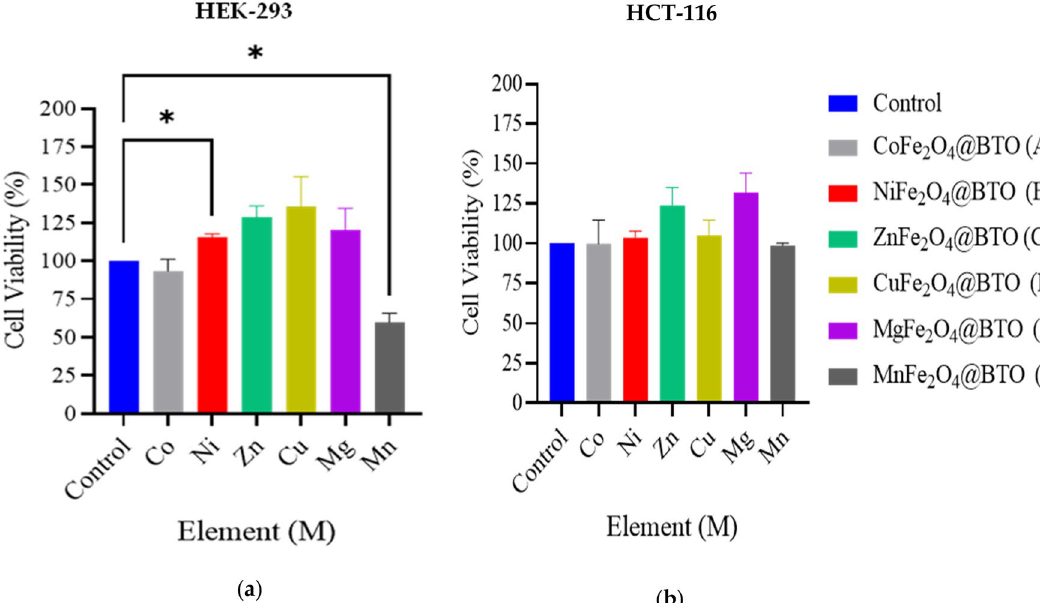
Figure 5. The average cell viability of ( a ) HEK-293 and ( b ) HCT-116 cell lines by MTT assay. Cells were treated with the following core composites MFe 2 O 4 @BTO (M = Co, Ni, Mn, Mg, Zn, and Cu) and treatment concentration was 141.75 µg/ 0.1 ml for 48 h. n = 4 and error bars ± S.E.M. * p < 0.05; versus